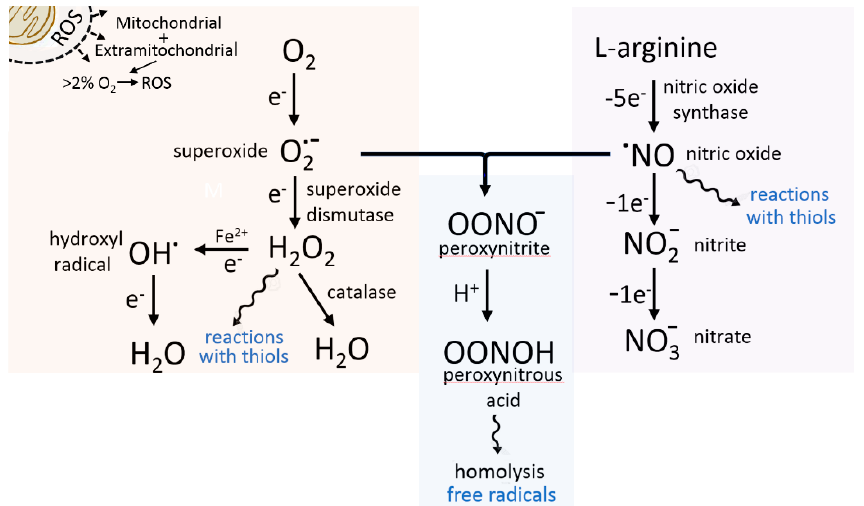
Figure 1. Schematic showing connectivity between mitochondrially generated superoxide and enzymically produced (NO synthase) nitric oxide. Peroxynitrous acid can decompose spontaneously to create further free radicals. The hydrogen peroxide reactions with protein thiols are a part of its regulatory role as biochemical signal molecule. S-nitrosylation reactions have complex signalling through to reservoir and NO transport functions.